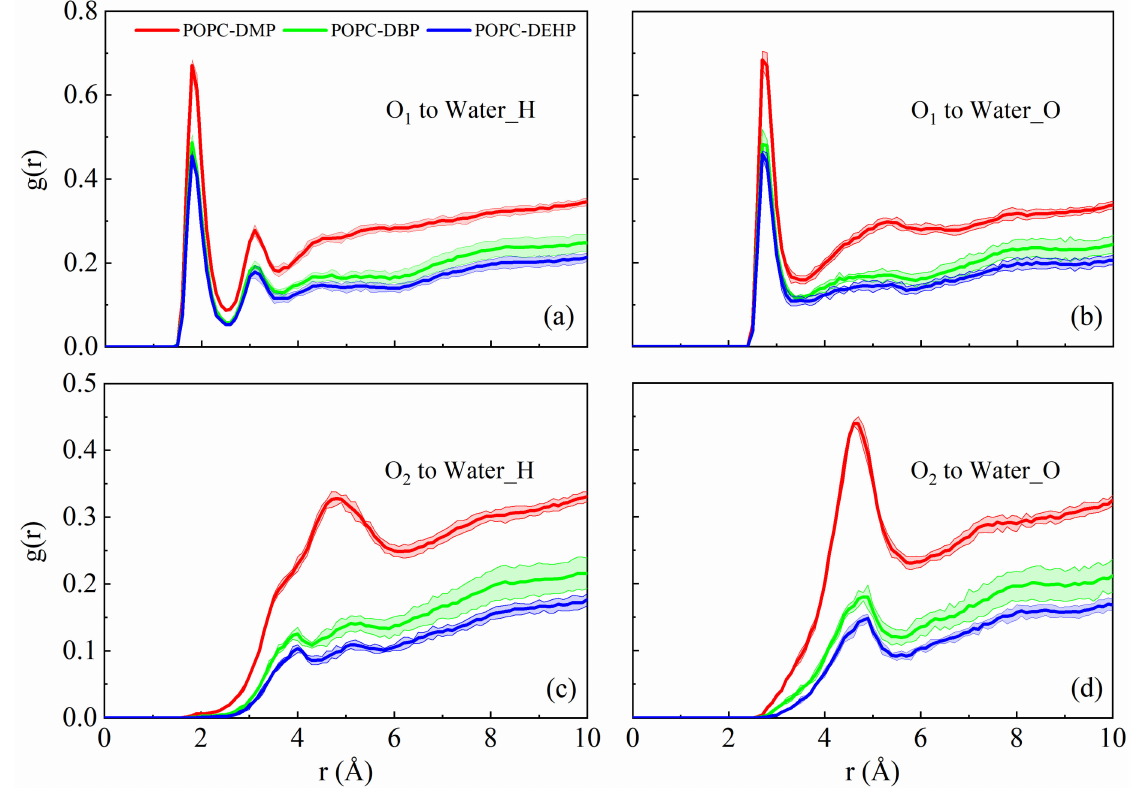
Figure S3b. From the g(r) and hydrogen-bond numbers (Figure S3a), DMP molecules were capable of forming much stronger hydrogen-bond interactions with aqueous phase than DBP and DEHP, which means it is easier for DMP to compete with lipid headgroups for hydrogen-bond binding sites of water.